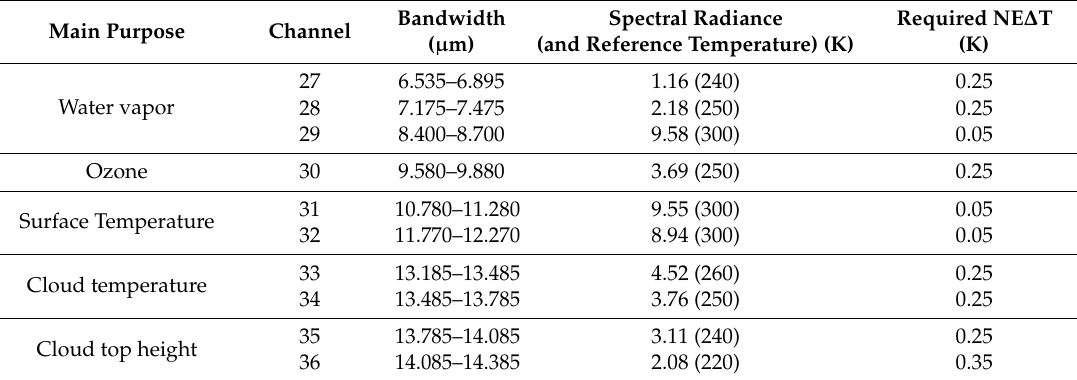
Table 1. Specifications of MODIS infrared channels: bandwidth ( µ m), spectral radiance (W/ ( m 2 · sr · um ) ), reference temperature (K), and noise-equivalent temperature difference NE ∆ T